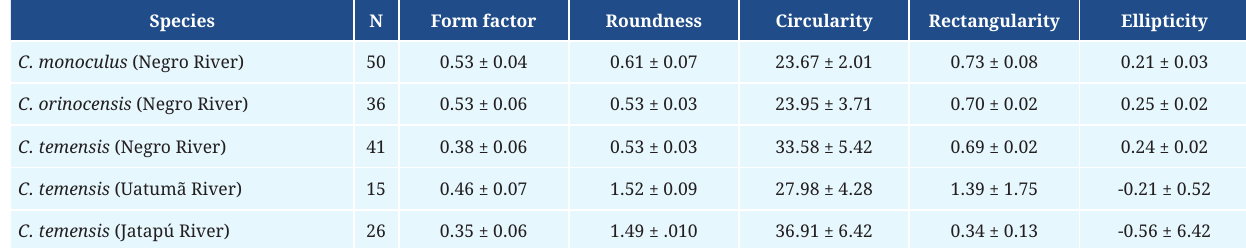
TABLE 2 | Mean (± standard deviation) of the shapes indices estimated from the morphometric parameters measured on otoliths of three Cichla species; N: number of individuals sampled.